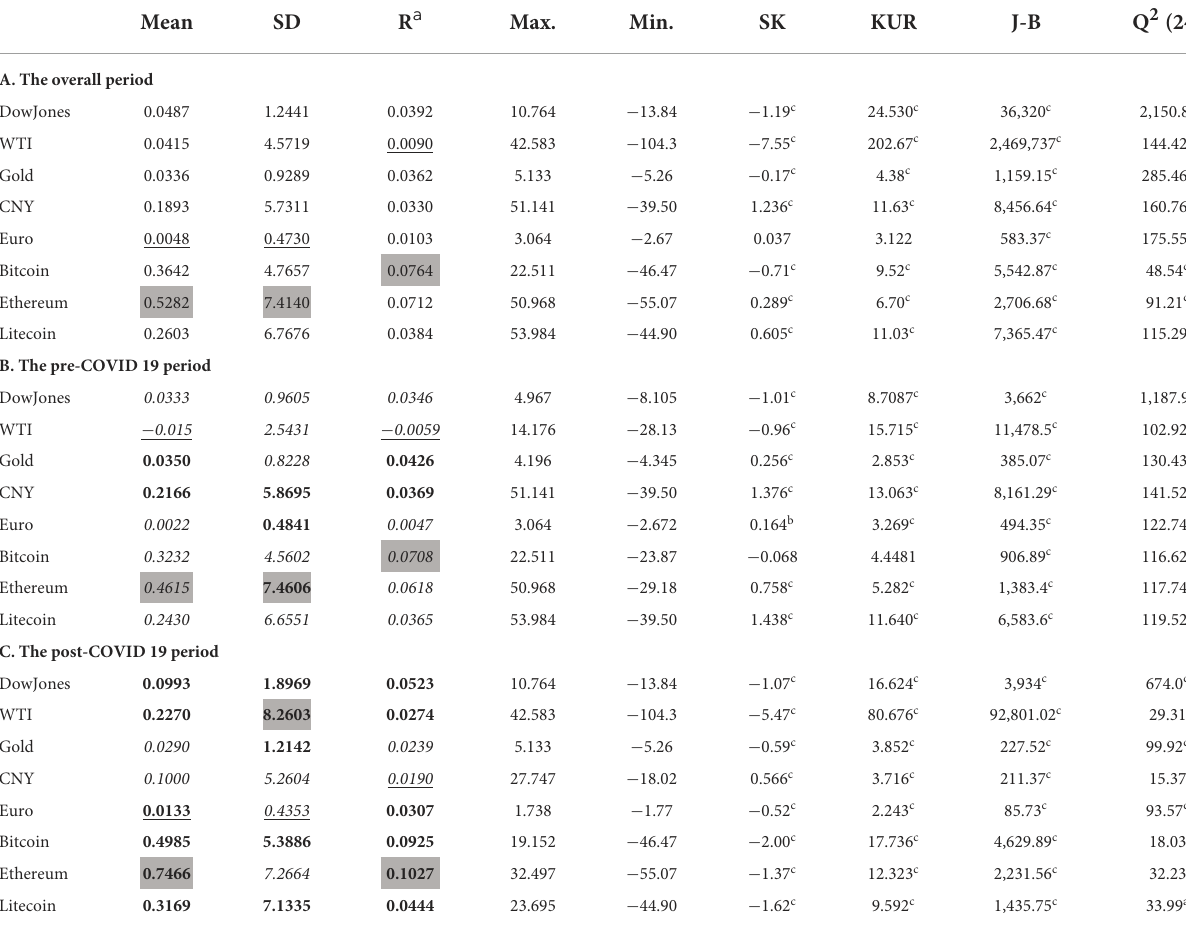
TABLE 2 Descriptive statistics of the daily return for the overall, pre- and post-COVID-19 periods. Mean SD R a